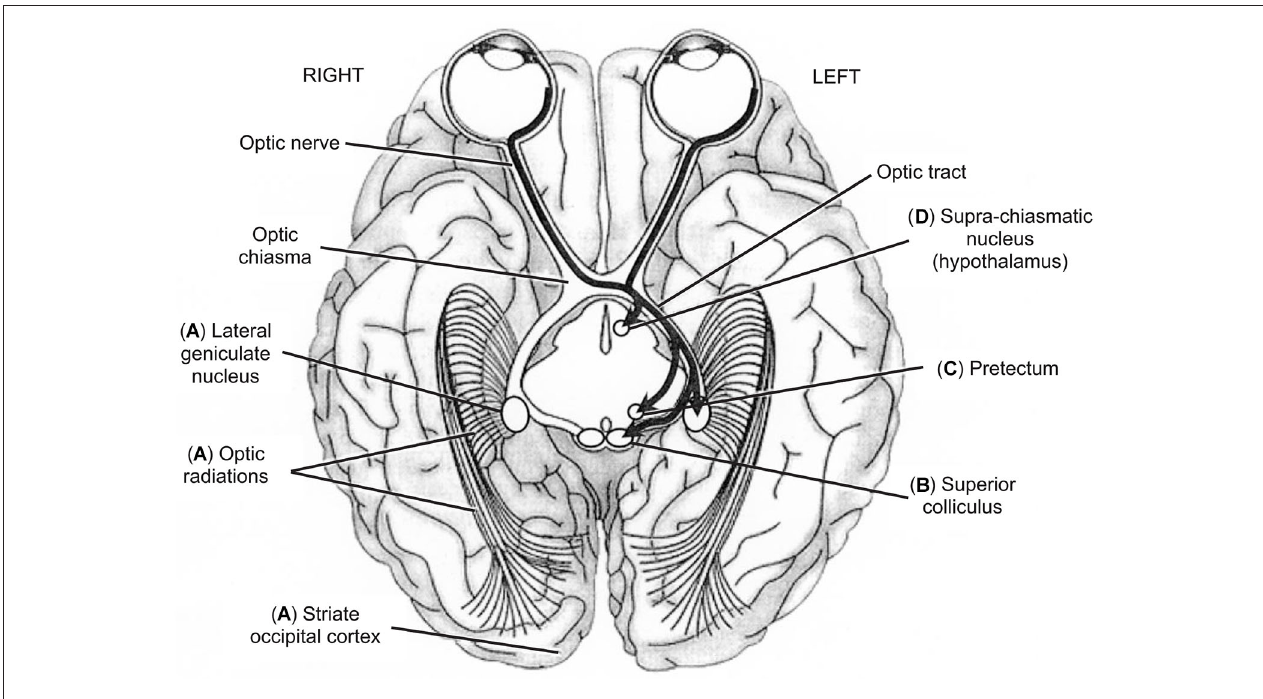
the different trajectories of ganglion neurons originating in leftward hemi-retinas (temporal hemi-retina of the left eye and nasal hemi-retina of the right eye). Ganglion neurons originating in rightward hemi-retinas exhibit mirror trajectories but are not illustrated here for clarity of display. From O.A. Coubard (© O.A. Coubard, with